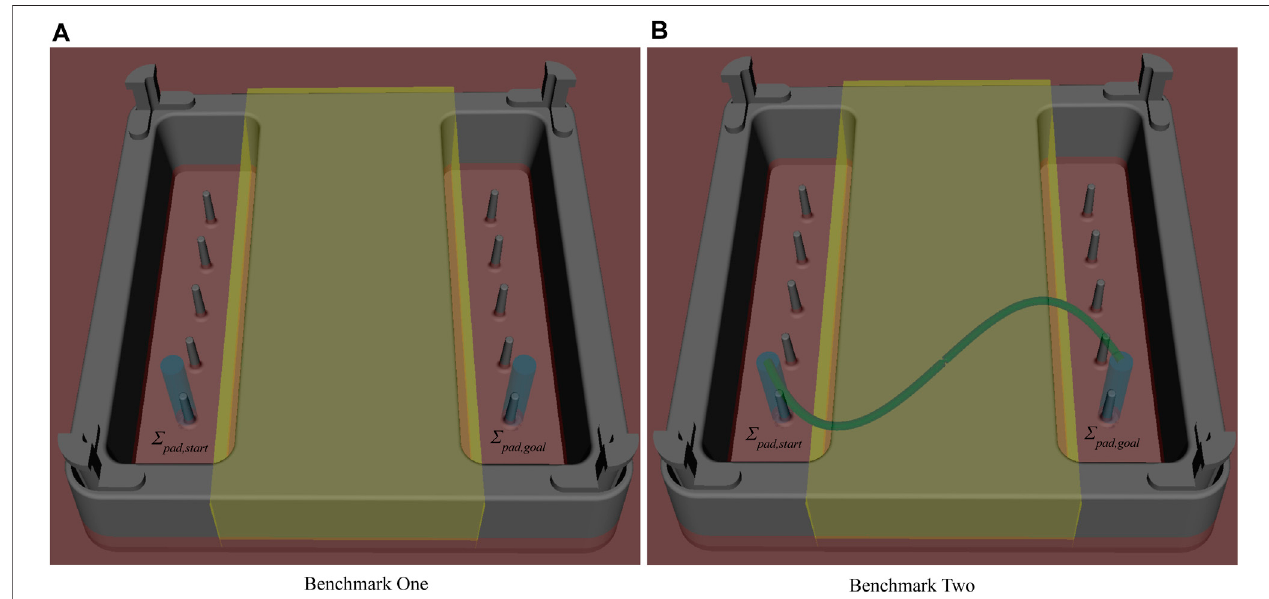
FIGURE3 | The training pad used for the benchmark scenarios isshown. Σ pad , start isthe initial pose ofthe ring and Σ pad , goal its goal pose. Theblue cylinders depict theAFs.TheyellowboxdepictstheRFandtheredareavisualizestheCartesianworkspacelimitin z -axis.Togethertheyhelpavoidcollisionsbetweentheinstrumentand the trainings pad. (A) depicts the fi rst benchmark scenario consisting of an unconstrained pick and place task. (B) displays the second benchmark scenario. The constrained pick and place task is realized by an sinus-shaped AF for the follow_path SCT. It is shown by the green curve.